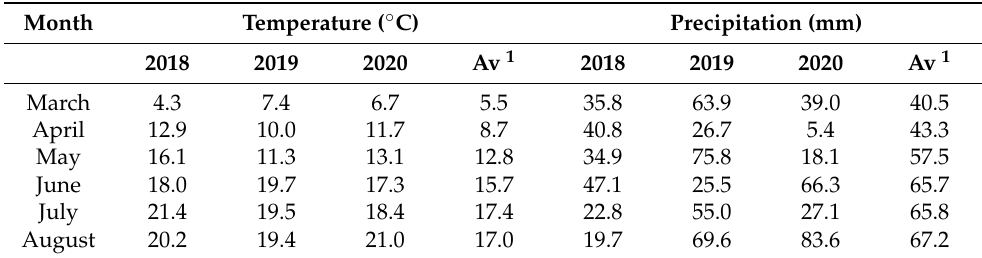
Table 1. Mean temperature ( ◦ C) and precipitation (mm) for March to August at Campus Klein- Altendorf (Germany) in the experimental years compared to the long-term average (1956–2019).